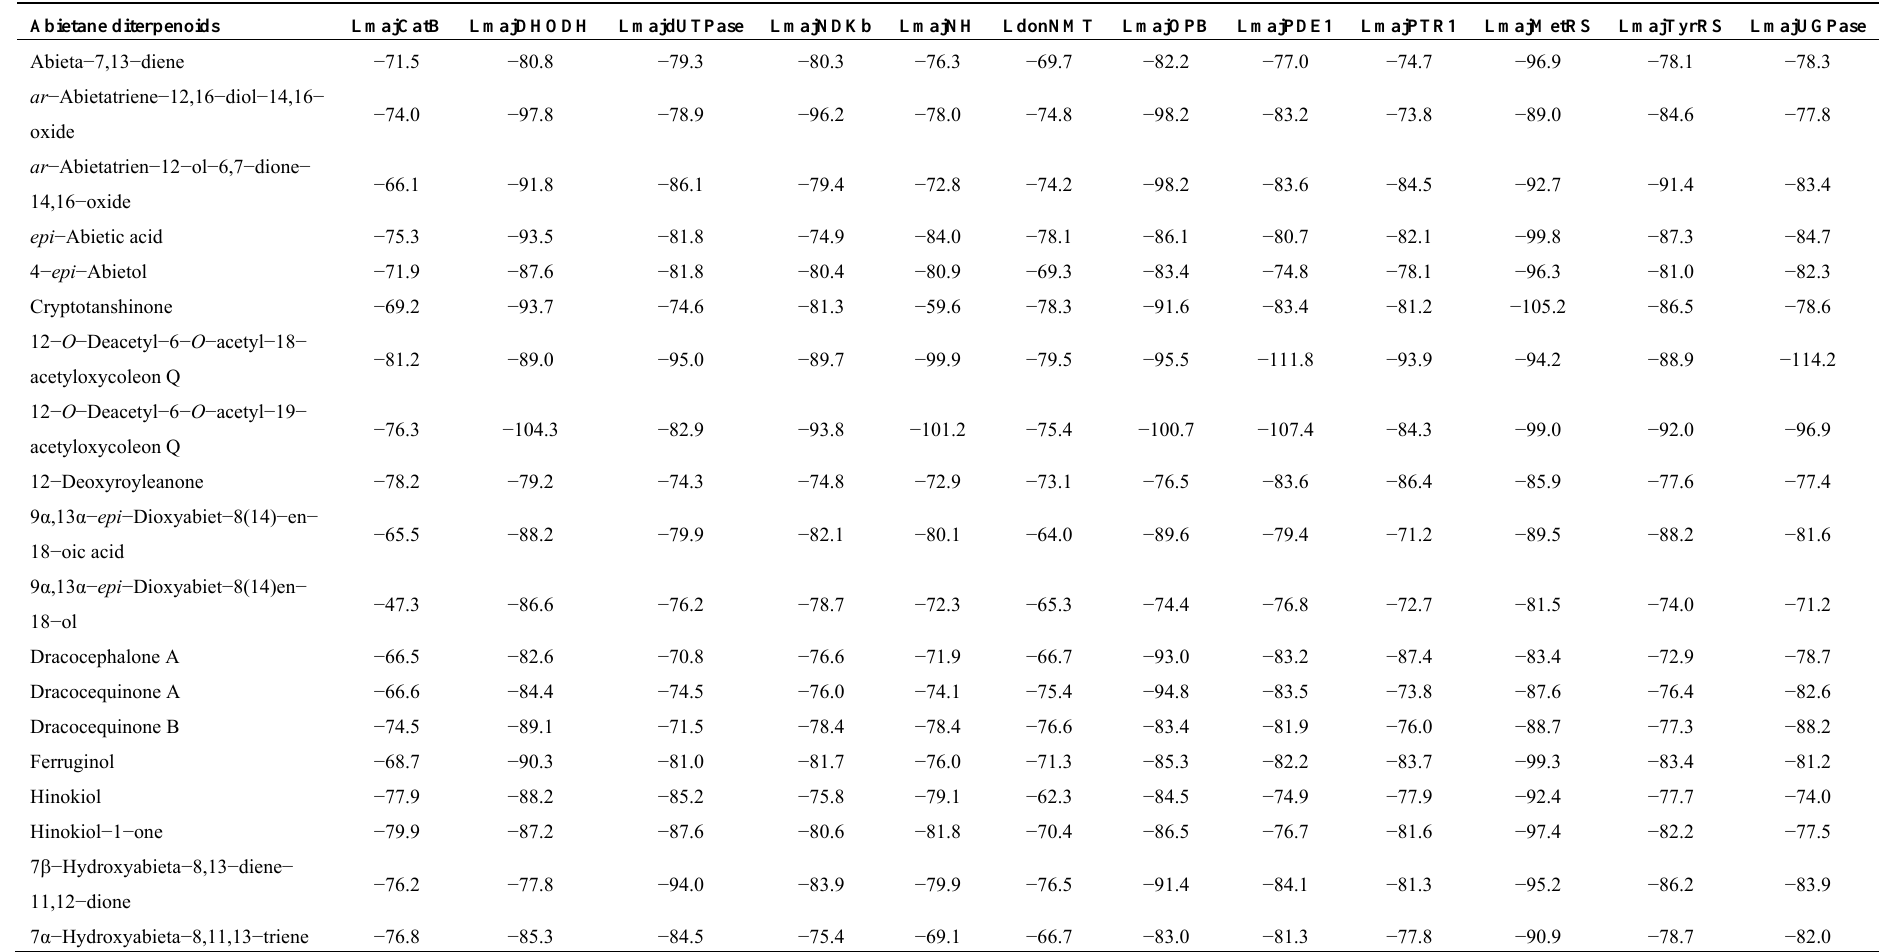
Table 16. MolDock docking energies (kJ/mol) of abietane diterpenoids with Leishmania major protein